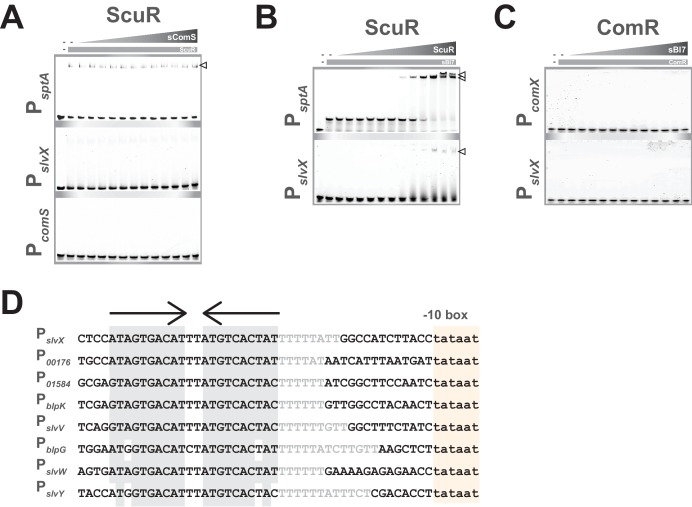
Promoter and peptide specificities toward ScuR and SarF.(A) Mobility shift assays of comS, slvX and sptA promoter probes conducted with purified ScuR and decreasing concentrations of the non-cognate sComS peptide (gray triangles; 2:2 dilutions from 20 µM). Probes are 30 bp (or 40 bp for PsptA), were Cy3-conjugated and used at 40 ng. Protein concentration remains constant (gray boxes; 4 µM). Open triangle showcases binary complexes (ScuR-DNA). (B) Mobility shift assays of slvX and sptA promoter probes conducted with sBI7 peptide and decreasing concentrations of purified ScuR (gray triangles; 2:2 dilutions from 8 µM). Probes are 30 bp (PslvX) or 40 bp (PsptA), were Cy3-conjugated and used at 40 ng. Peptide concentration remains constant (gray boxes; 1 µM). Open triangles showcase ternary complexes (sBI7-ScuR-DNA). (C) Mobility shift assays of comX and slvX promoter probes conducted with purified ComR and decreasing concentrations of the non-cognate sBI7 peptide (gray triangles; 2:2 dilutions from 20 µM). Probes are 30 bp, were Cy3-conjugated and used at 40 ng. Protein concentration remains constant (gray boxes; 4 µM). (D) Nucleotide alignment of bacteriocin-related gene promoters. The pseudo-palindromic stretches (converging arrows) and the sigma-bound DNA sequence (−10 boxes) are highlighted in gray or yellow, respectively. The characteristic T-rich region is gray font.